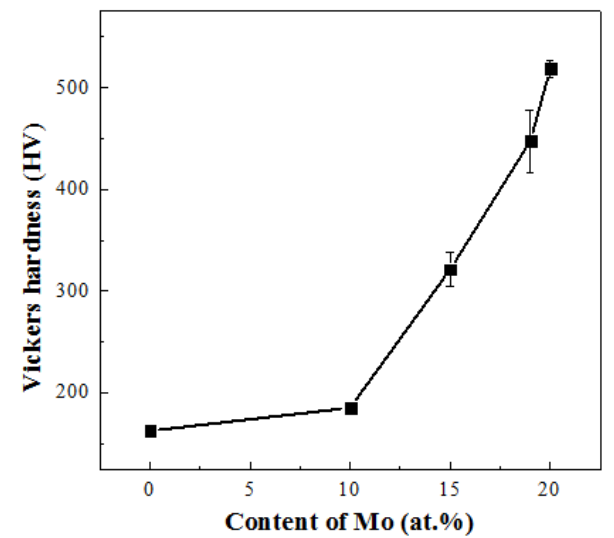
Figure 5. Vickers hardness as a function of Mo content for (CoCuFeNi) 100- x Mo x HEAs.